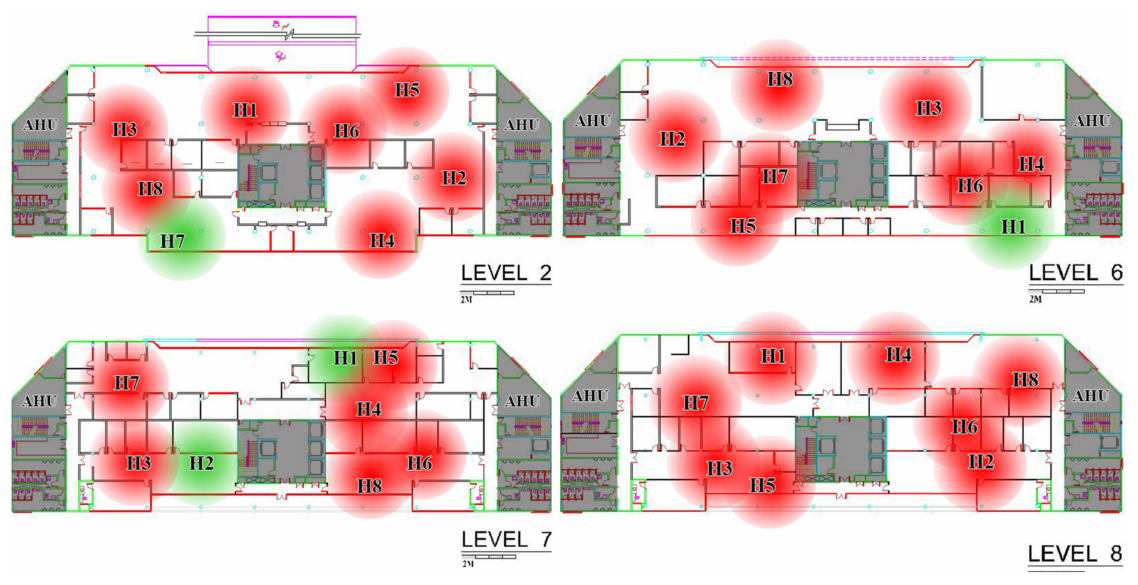
Figure 5. Locations of data loggers and perceived comfort in different floors. HOBO data loggers were located at H1–H8 (close to the curtain walls and deep inside the offices). AHU is the air-handling unit.